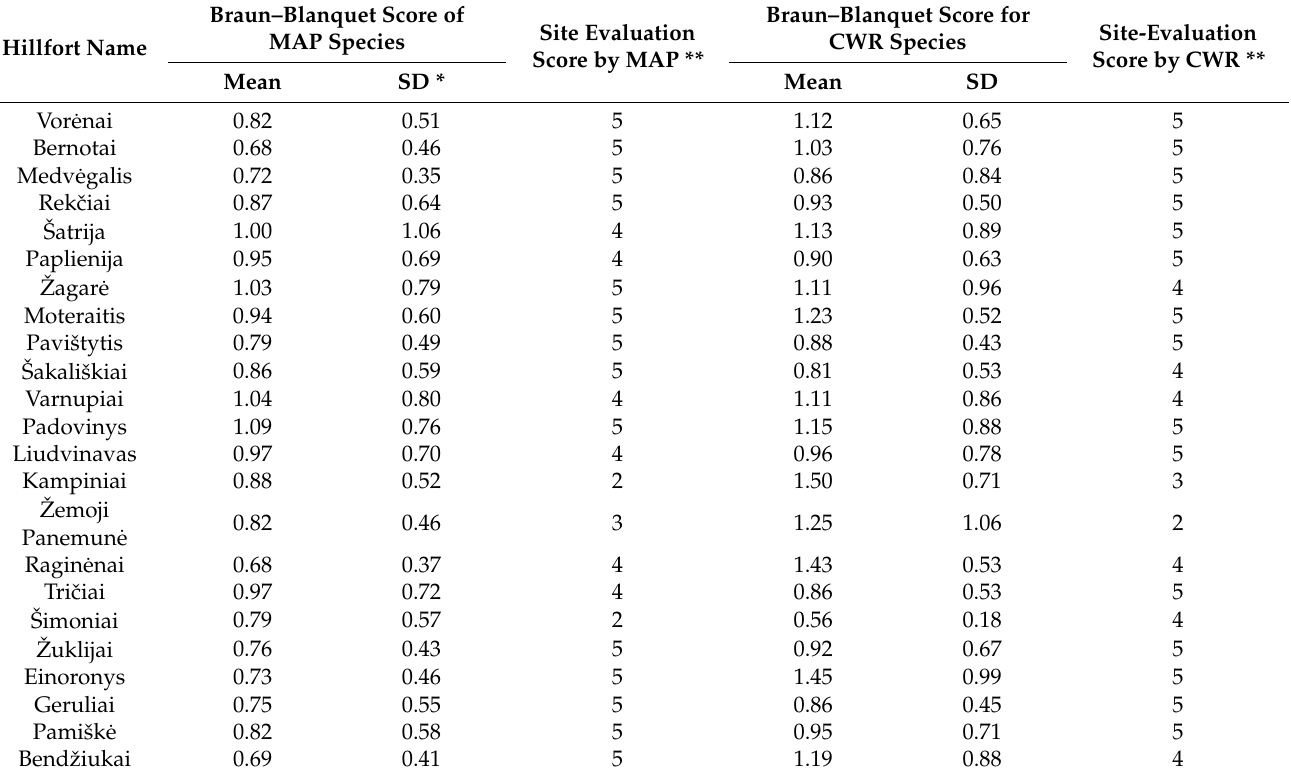
Table 2. Hillfort-site evaluation by MAP- and CWR-species cover-abundance estimated by mean Braun–Blanquet